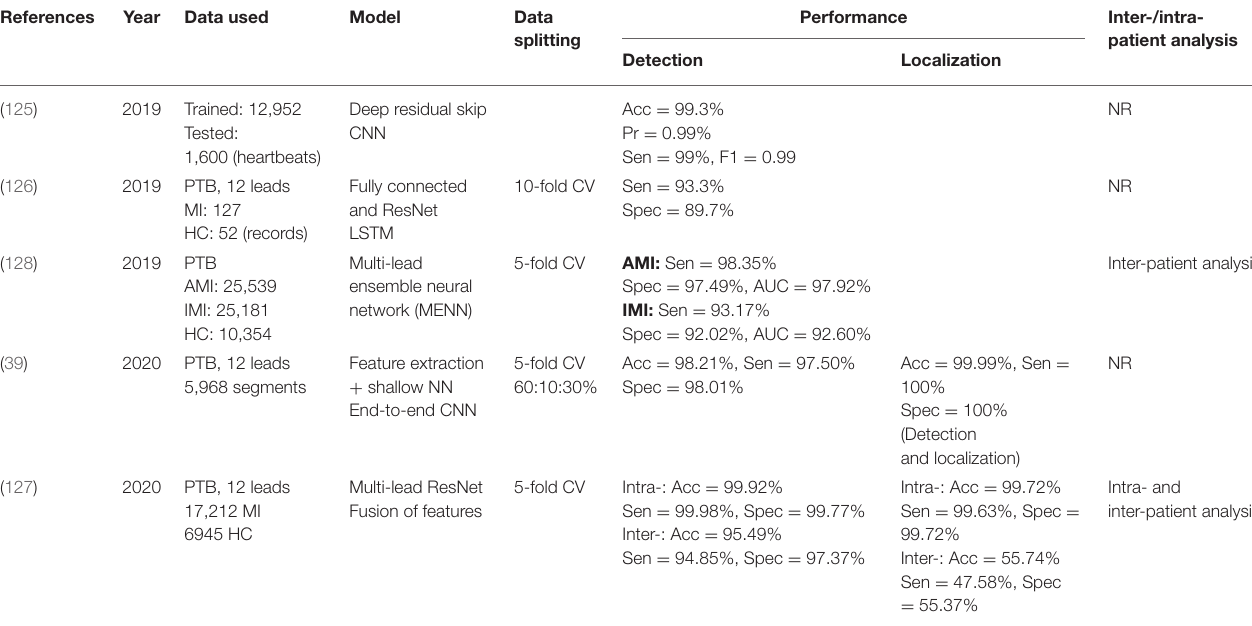
TABLE 8 | Properties of some notable ResNet-based ECG MI detection and